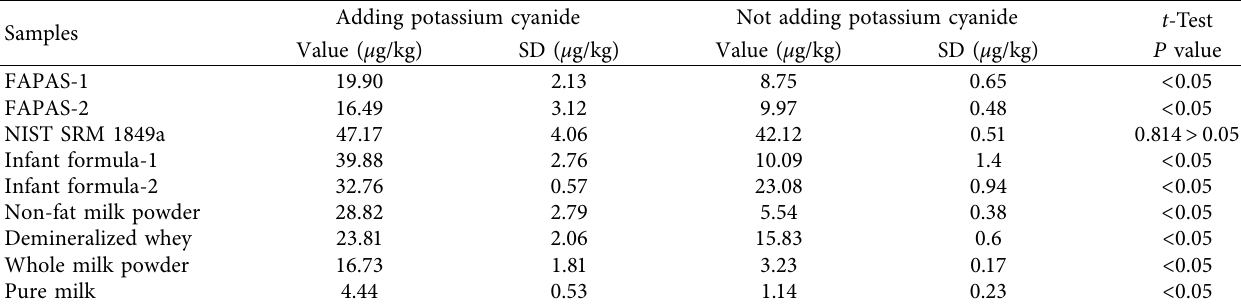
Figure 2: Mass spectrum of full scan and daughter scan of VB 12 and isotope-labeled VB 12. (a) MS scan of VB 12 (b) Full MS scan of (c) Daughter scan of VB 12 (d) Daughter scan of 13 C 7- VB 12 . Table 2: Comparison of results by adding potassium cyanide or not. Adding potassium cyanide Not adding potassium Samples